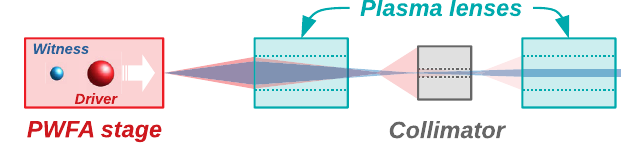
FIG. 2. Layout of the extraction system consisting of two active-plasma lenses employed as plasma lenses and a lead collimator between them. The focusing strengths of the lenses are set up to rapidly catch the witness bunch (blue) downstream from the PWFA stage and allow for its transport without any loss of charge. The driver bunch (red) has a lower average energy and is thus overfocused: Its spot size at the collimator entrance is larger than the aperture, and its charge is thus cut